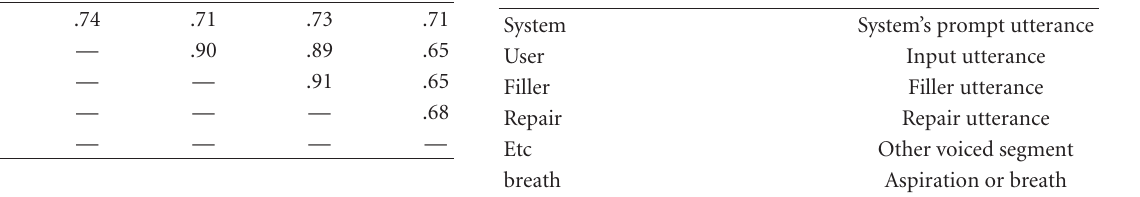
Figure 4: Mean length of the period until user’s input. Table 4: Classification of speech